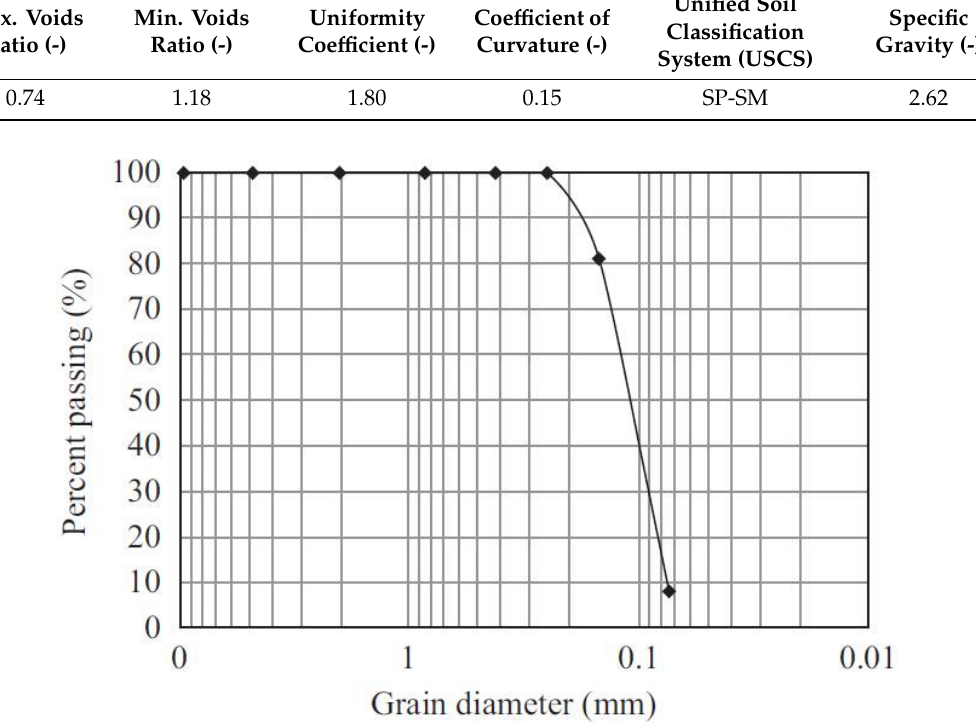
Figure 5. Grain size distribution curve of silty sand (adapted from [20]).